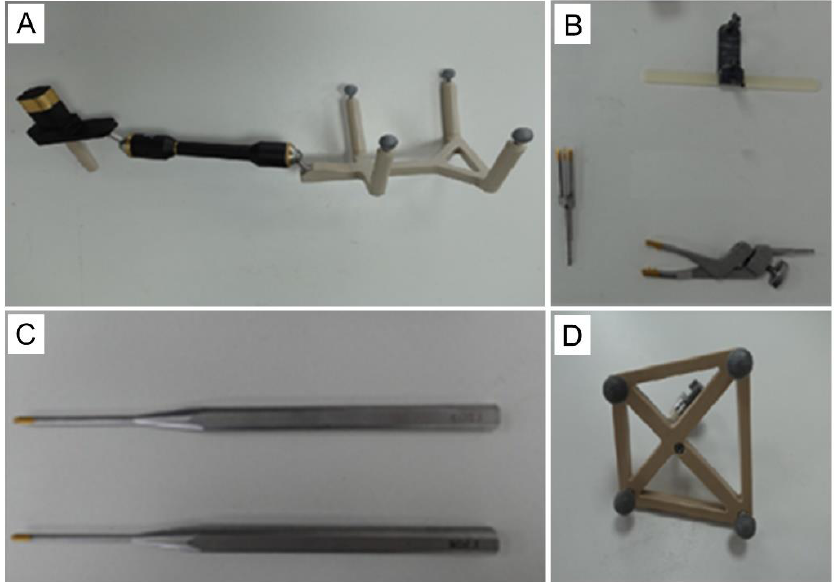
Figure 2. The toolset of the Tuoshou robot. ( A ) Calibrator. ( B ) Connectors. ( C ) Cannula. ( D ) Tracker.